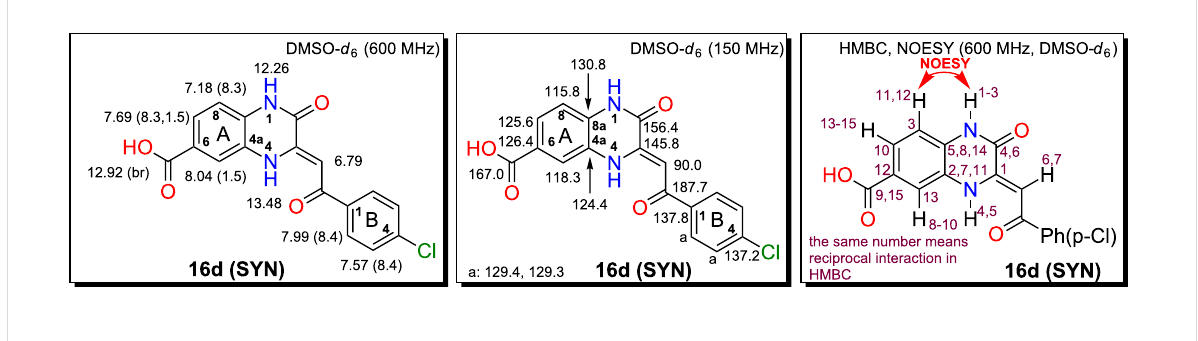
Figure 3: NMR assignments for compound 16d .